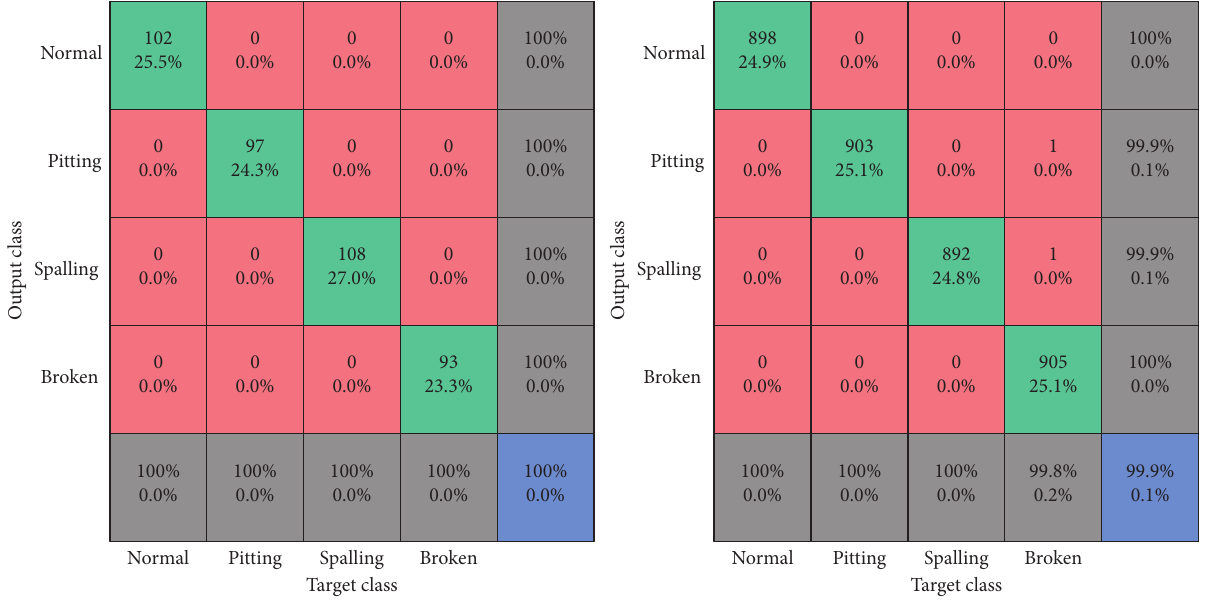
Figure 12: Confusion matrix of training samples (left panel) and test samples (right panel) of worm gear dataset.